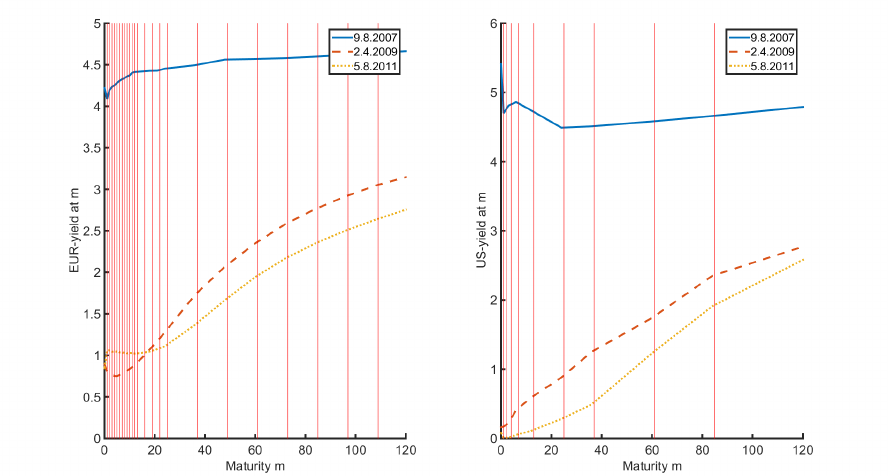
Figure 3. Yield curves for EUR ( left ) and the US ( right ). Parallels to the y-axis mark the maturities from the